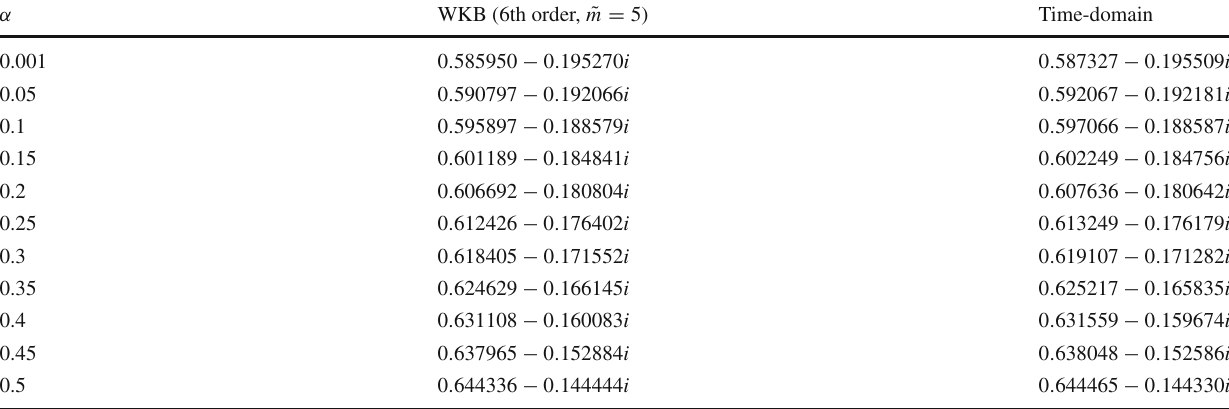
Table 1 The fundamental quasinormal mode of the scalar field ( (cid:11) = 1, n = 0, M = 1 / 2) as a function of α α WKB (6th order, ˜ m =